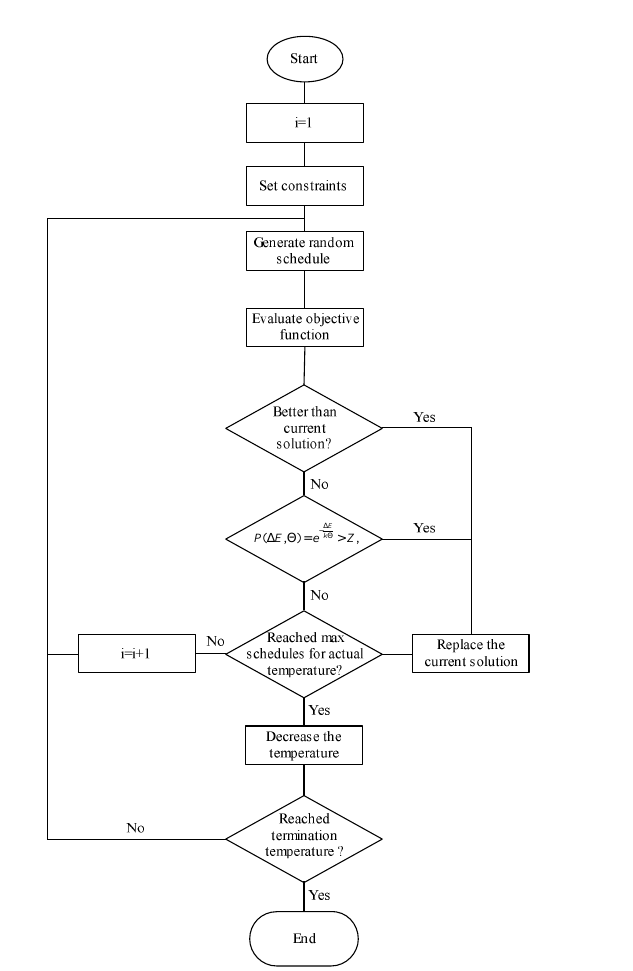
Figure 3 – Medical staff scheduling